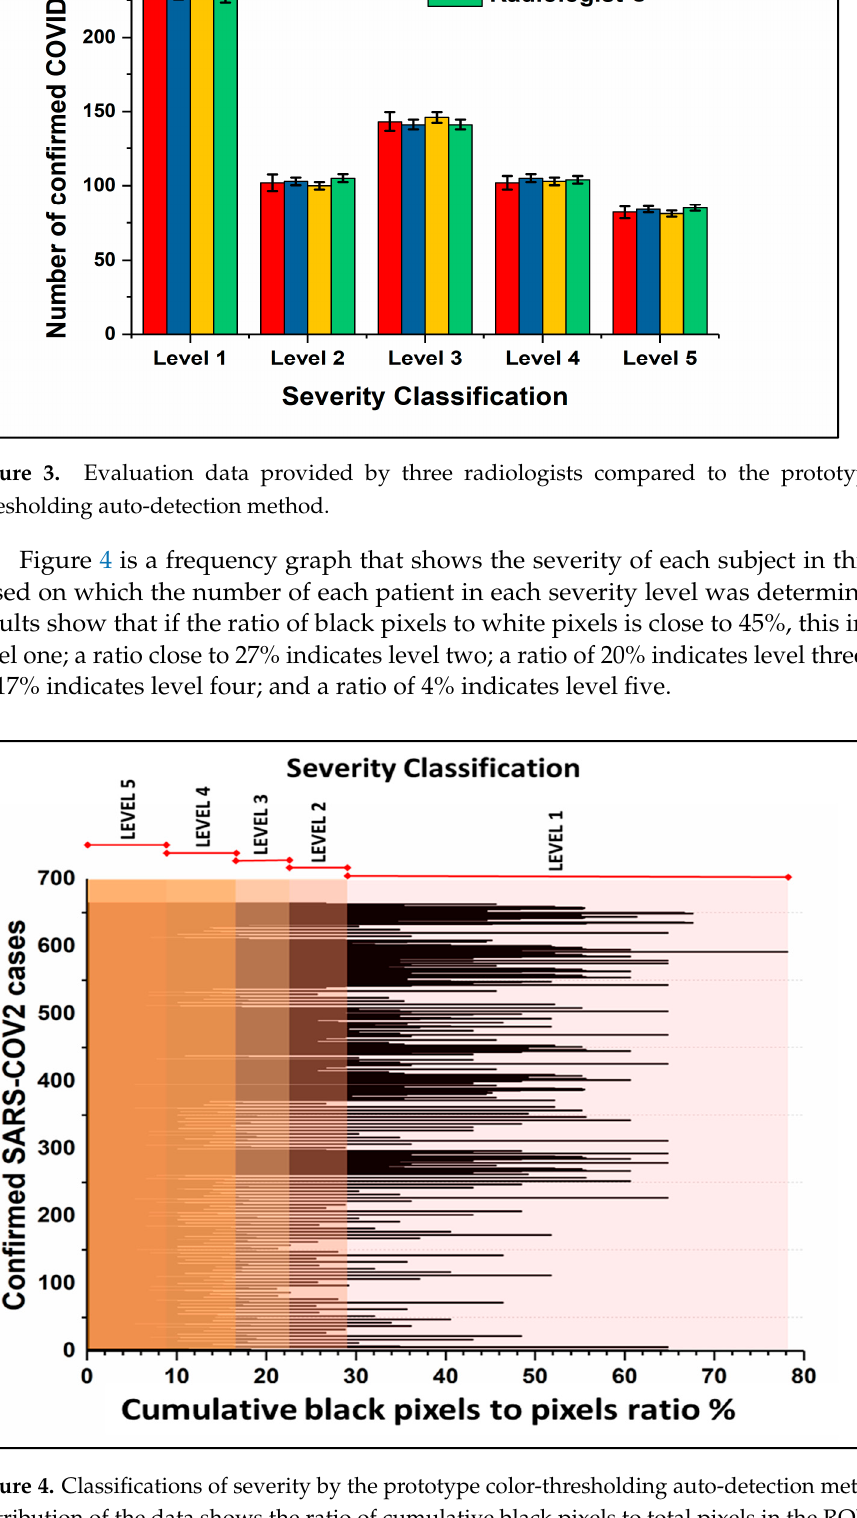
Figure 2. Chest X-ray images for five confirmed SARS-COV2 cases. These images show the levels of severity of inflammation in three different modes: original image mode (first row), multi-color thresholding mode (second row), and segmentation mode (third row).